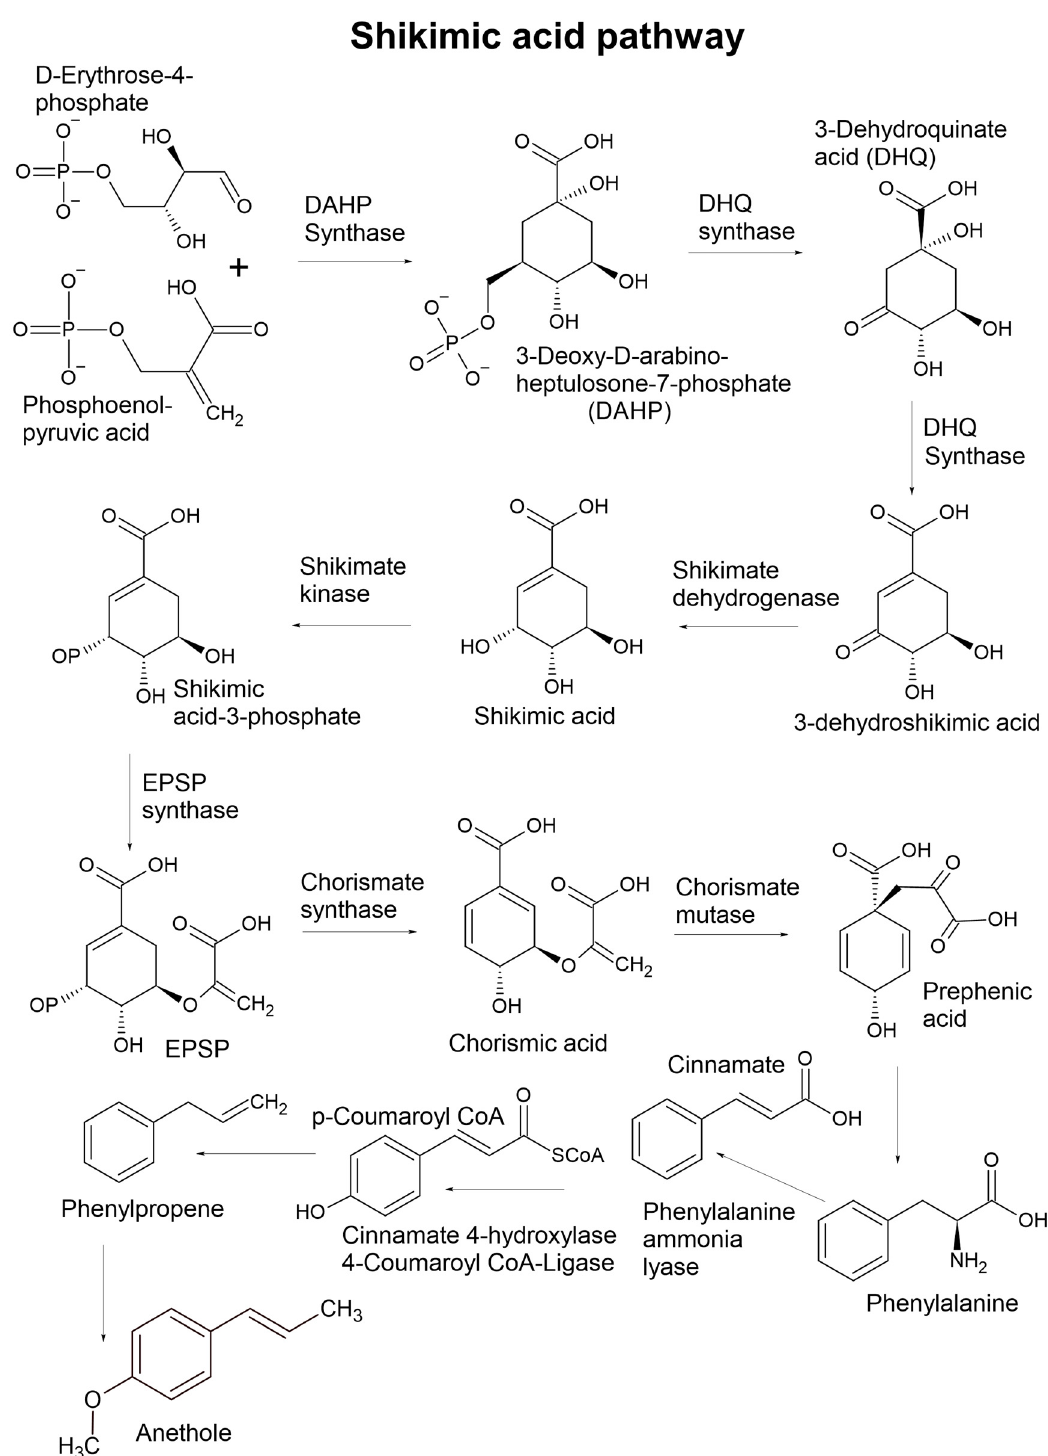
Figure 4. The shikimic acid biosynthetic pathway that creates phenylpropanoids.